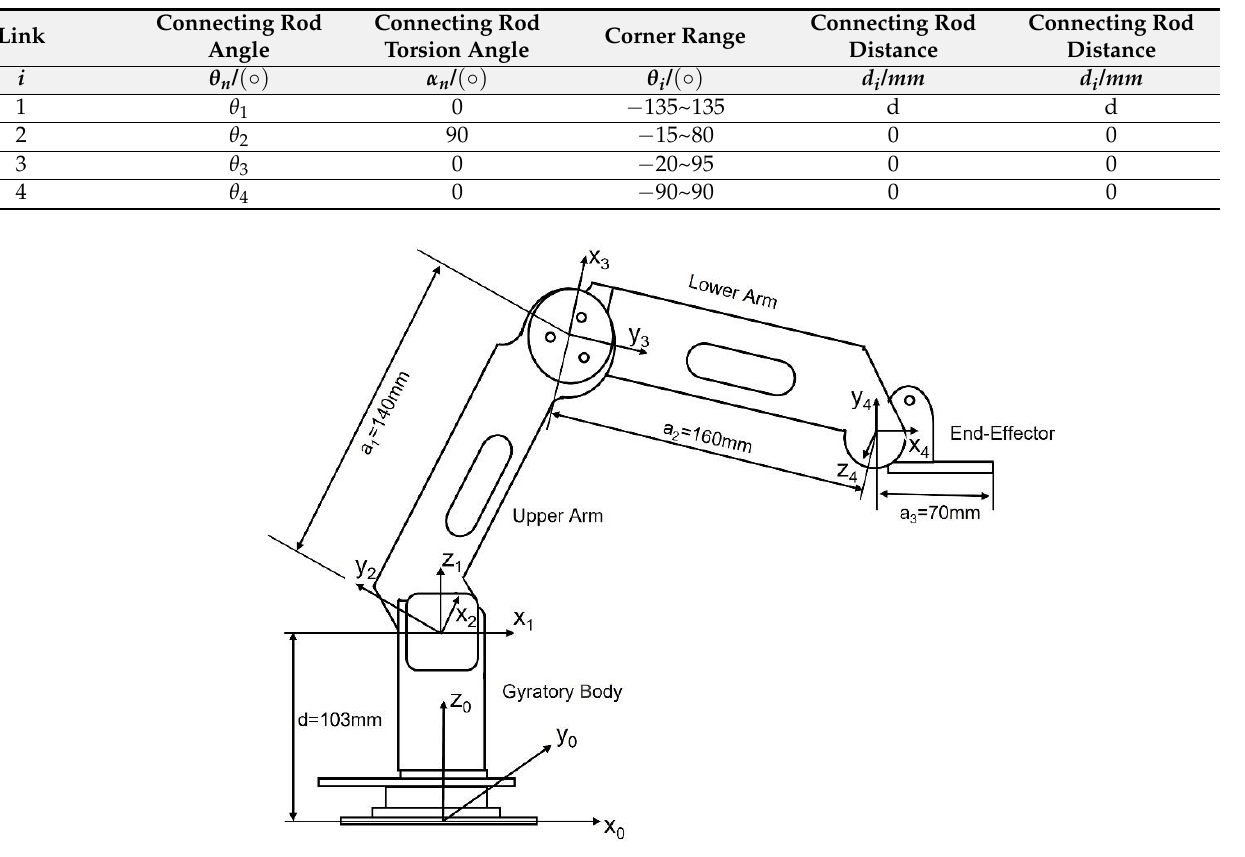
Figure 11. Robot arm model: set the coordinate system according to the D-H method.